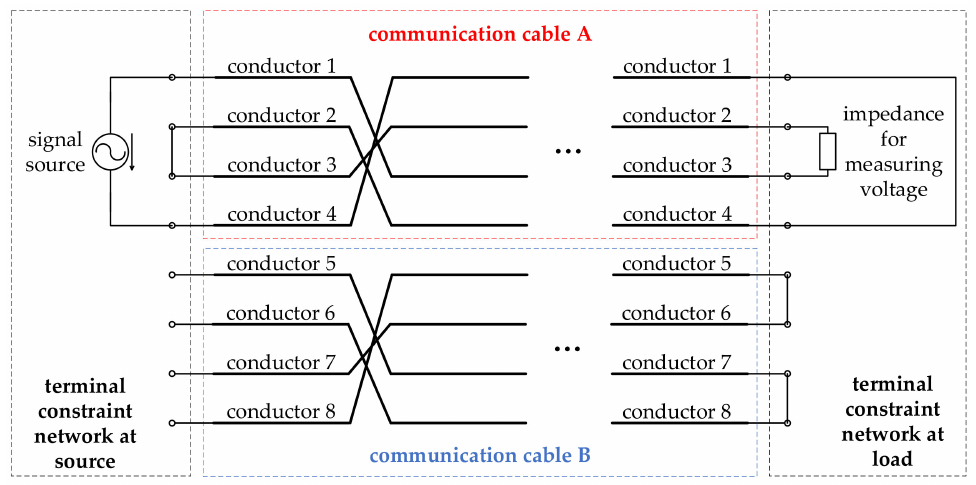
Figure 4. The schematic diagram of the specific terminal networks in a transmission line